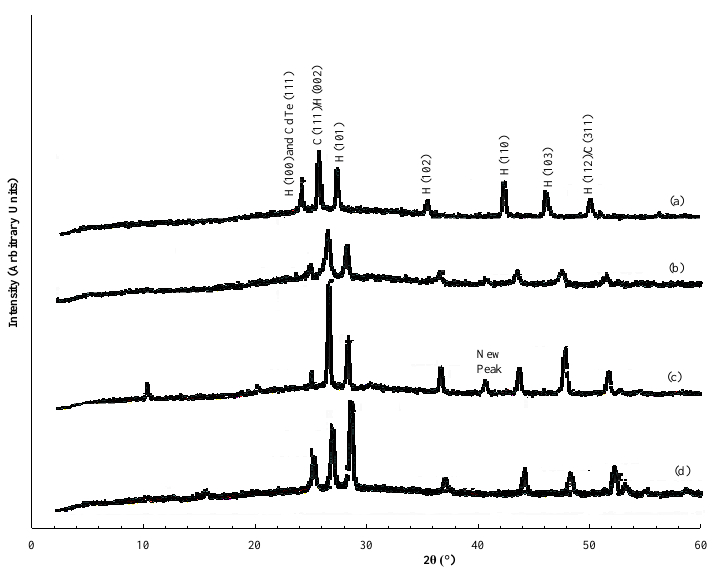
Figure 3. X-ray diffractograms of three CdS 1−y Te y films ( a – c ) with different Te content besides the diffractogram of as-depoited CdS:In film ( d ); Film ( a ) has the greatest Te content and film ( c ) has the smallest.